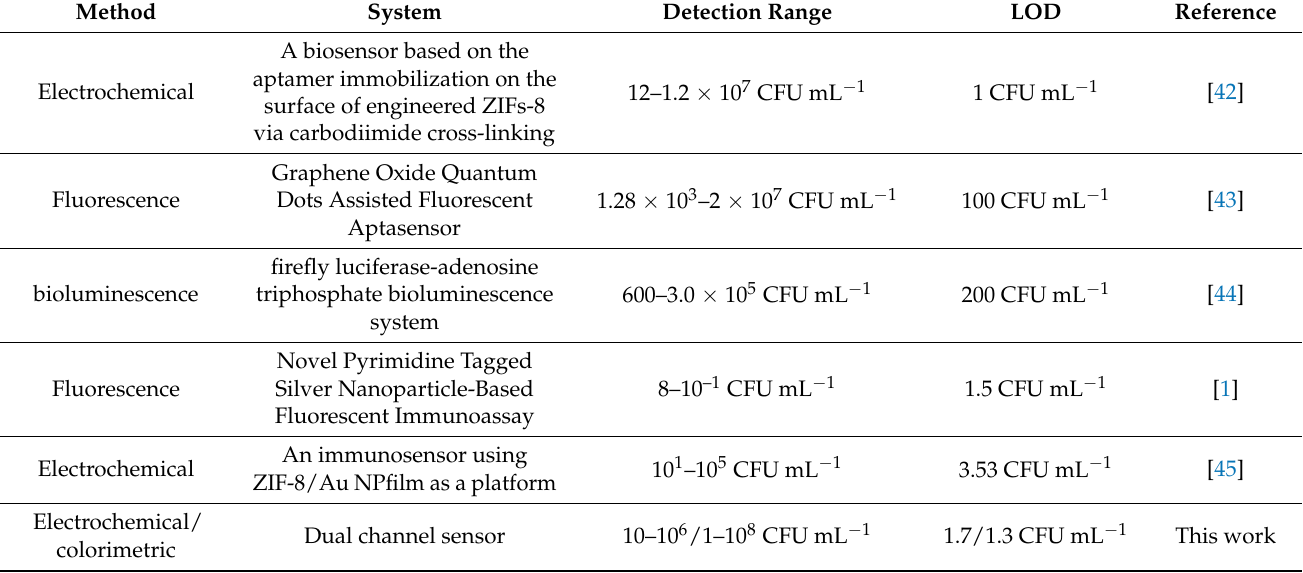
Table 2. Comparison of sensitivity for P. aeruginosa detection.